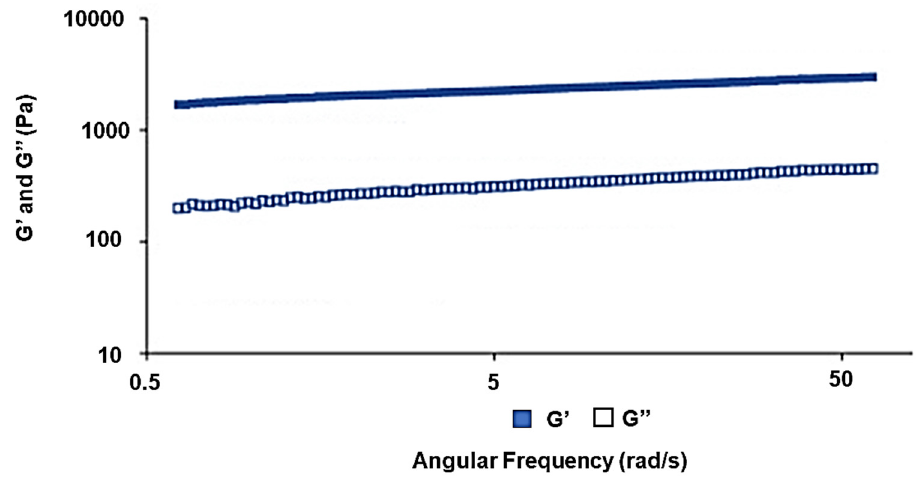
Figure 11. Elastic/storage modulus (G ′ ) and viscous/loss modulus (G”) vs. angular frequency.